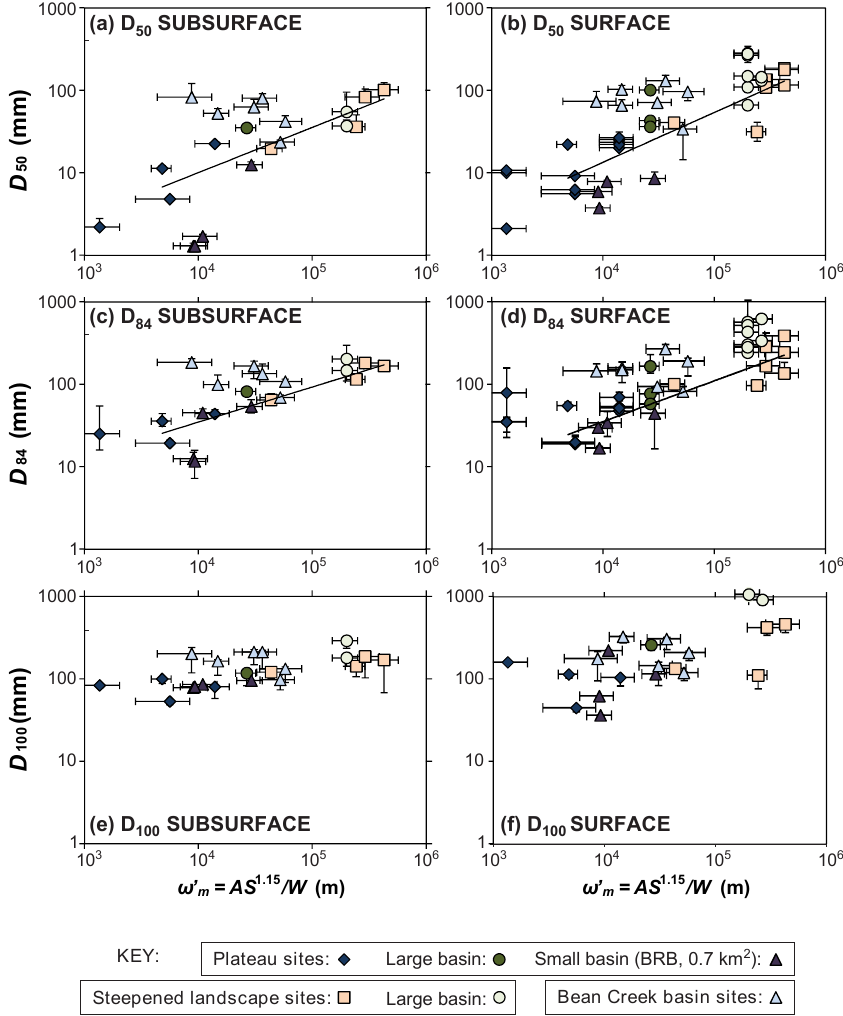
Figure 10. Fluvial sediment grain size as a function of ω (cid:48) m . Grain sizes are shown for both subsurface (left panels) and surface (right panels): D 50 (top panels), D 84 (middle panels) and D 100 (bottom panels). Note the log–log scale. Vertical error bars represent plus or minus values calculated according to procedure described in Sect. 2.3. Horizontal bars reflect variability of channel width at the scale of the 100m reaches considered (Sect. 2.3). We classify sites based on their position with respect to the topographic break in slope (see key and Fig. 5); Bean Creek sites are treated separately due to the lack of a clear morphological distinction between relict surface and steepened landscape. Lines in (a) to (d) represent best-fit power regression for Adams Creek sites (Table 1) and are shown as a reference for comparison with other sites. steepened landscape sites. Similarly, the data points from the sites along the incised Little North Fork River (open circles in Fig. 10) fall within the grain size and ω (cid:48) domains de- m lineated by the steepened landscape data points. The Bean Creek sites sit at an intermediate position between the steep- ened landscape and plateau sites in terms of flow competence but share the range of grain size with steepened landscape